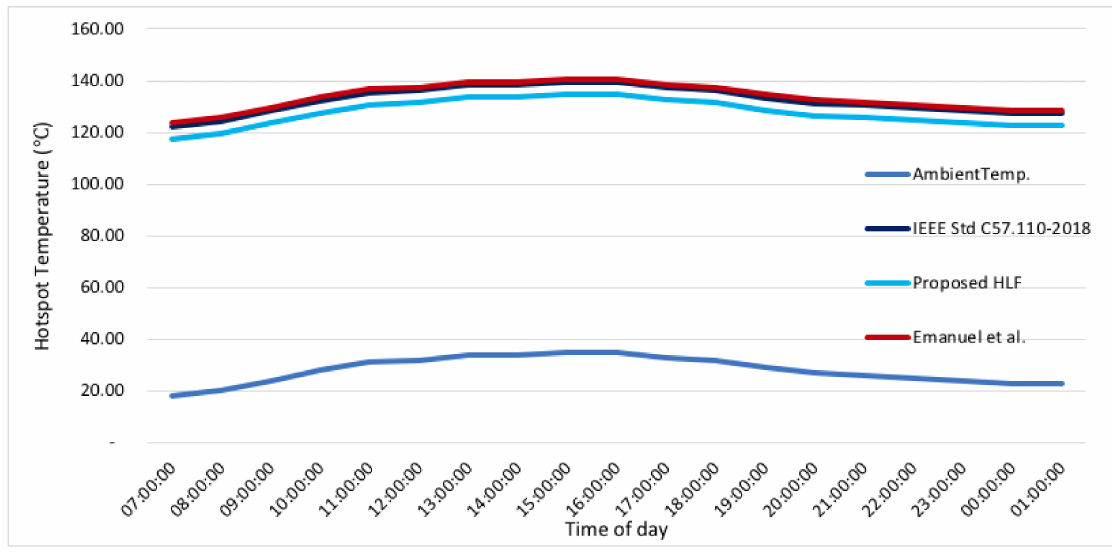
Figure 8. Hourly HST variation, 40 MVA 88/11 kV distribution